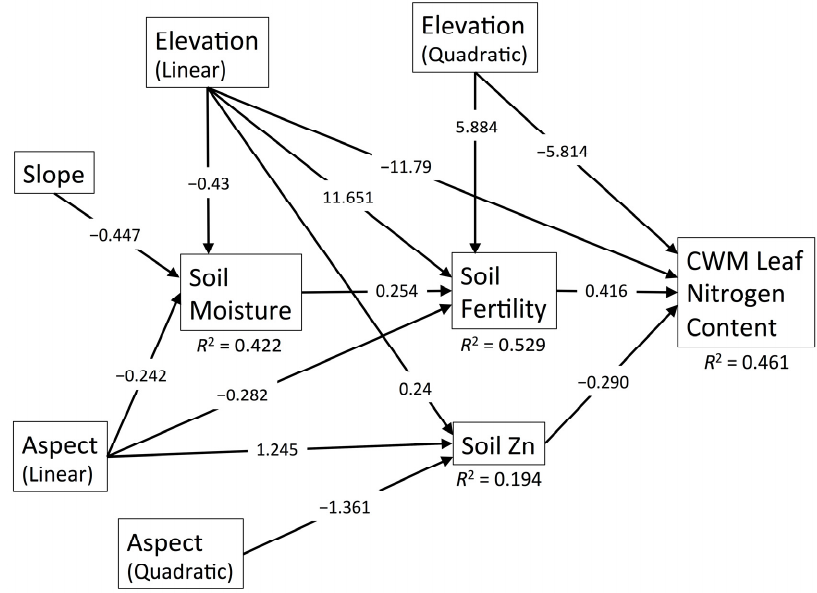
Figure 6. Path diagram for community ‐ weighted mean leaf nitrogen content. Standardized path coefficients are given. R 2 values are total explained variance. coefficients are given. R 2 values are total explained